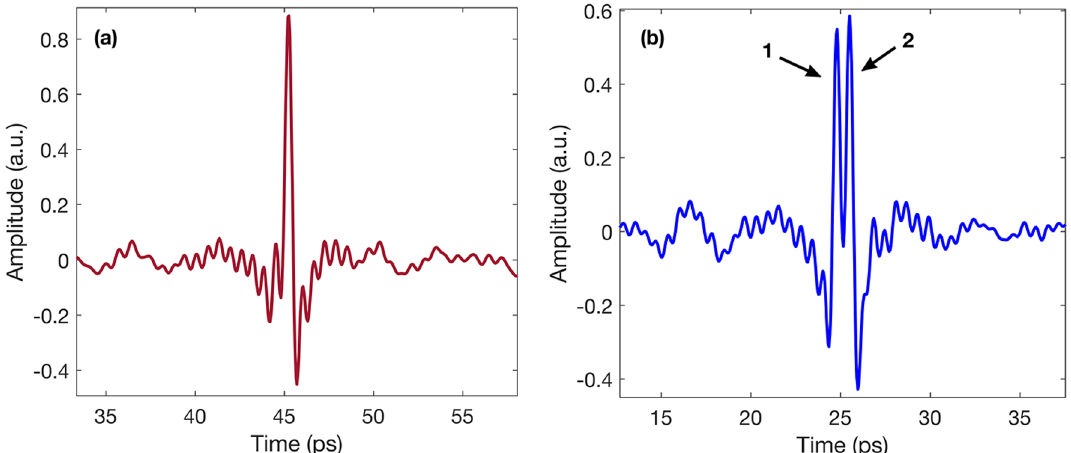
Figure 5. Comparison of regular and irregular waveforms for the mapping algorithm. ( a ) Shows a regular waveform corresponding to an area on the painting where the layers were homogeneous and no irregularities were present. ( b ) Shows an example of an irregular waveform, where layer detachment is denoted by the two peaks located between 20–30 ps. As peak 2 has an amplitude greater than 80% of peak 1, the algorithm saved the coordinates of this